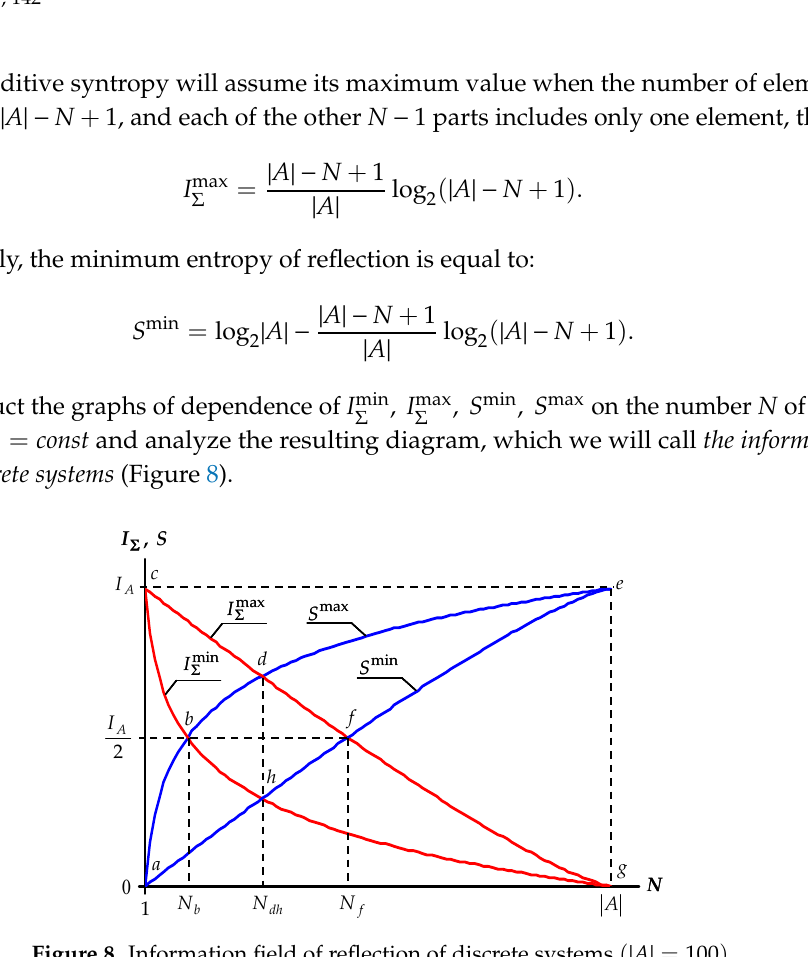
Figure 8. Information field of reflection of discrete systems )100(